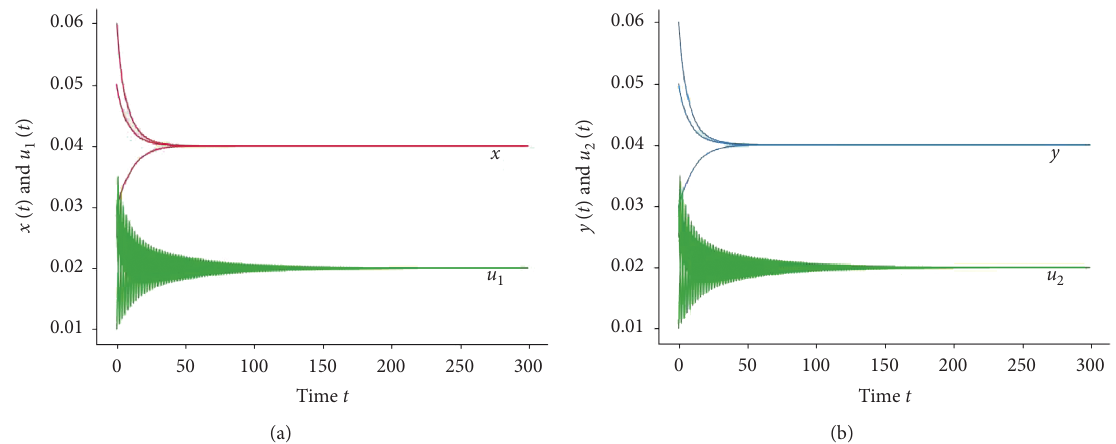
Figure 3: Dynamic behaviors of system (29) with the initial conditions (0.03, 0.03, 0.01, 0.01), (0.05, 0.05, 0.03, 0.03), and (0.06.0.06, 0.025, 0.025) when r � 2 . 1 ,a � 2 .b � 1 , e � 1 , η � 2 , and D �